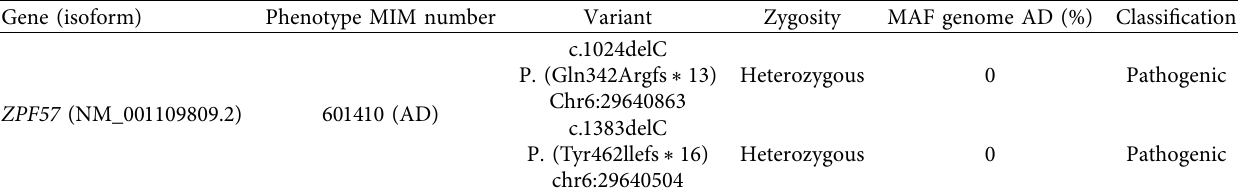
Table 1: Molecular genetic analysis for neonatal diabetes